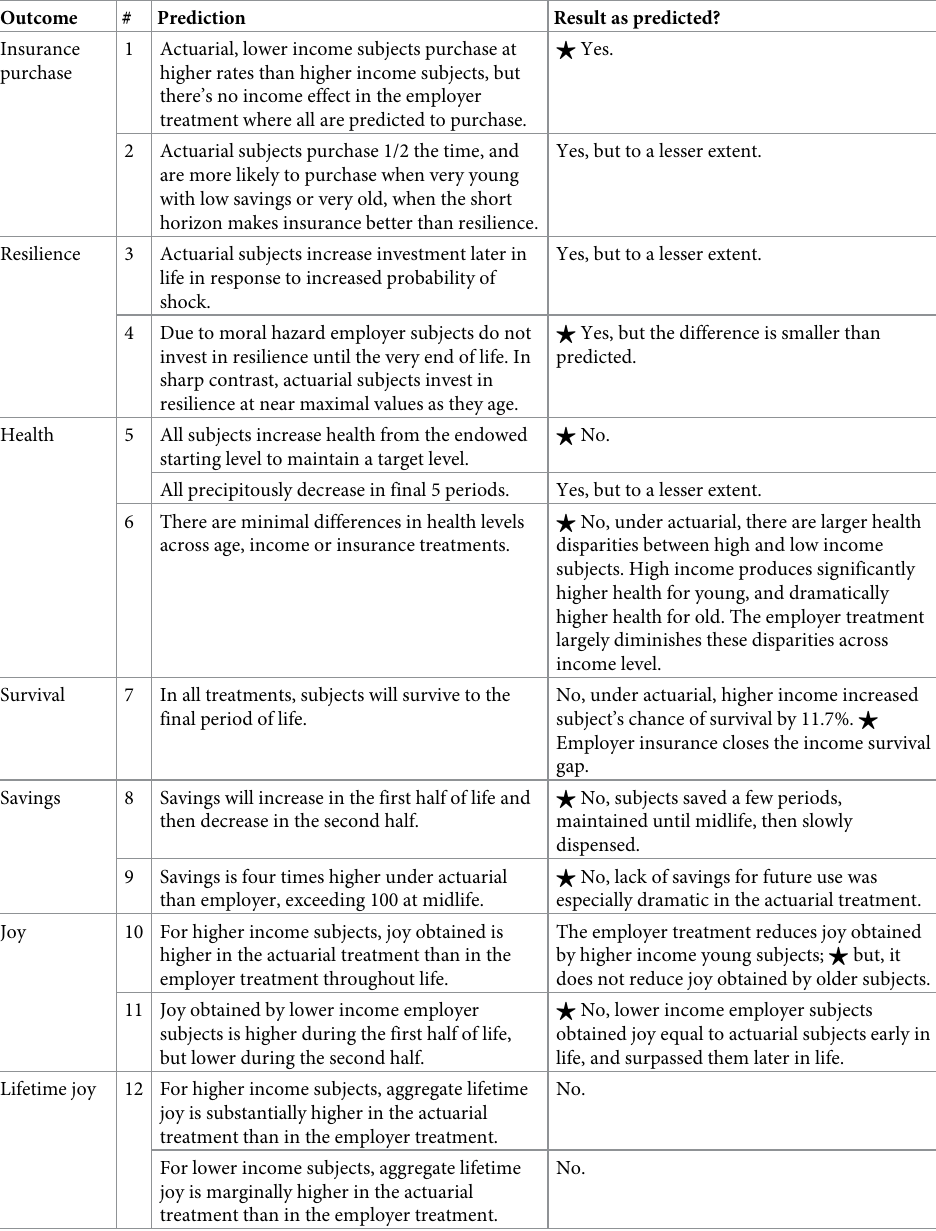
Table 6. Summary of predictions and